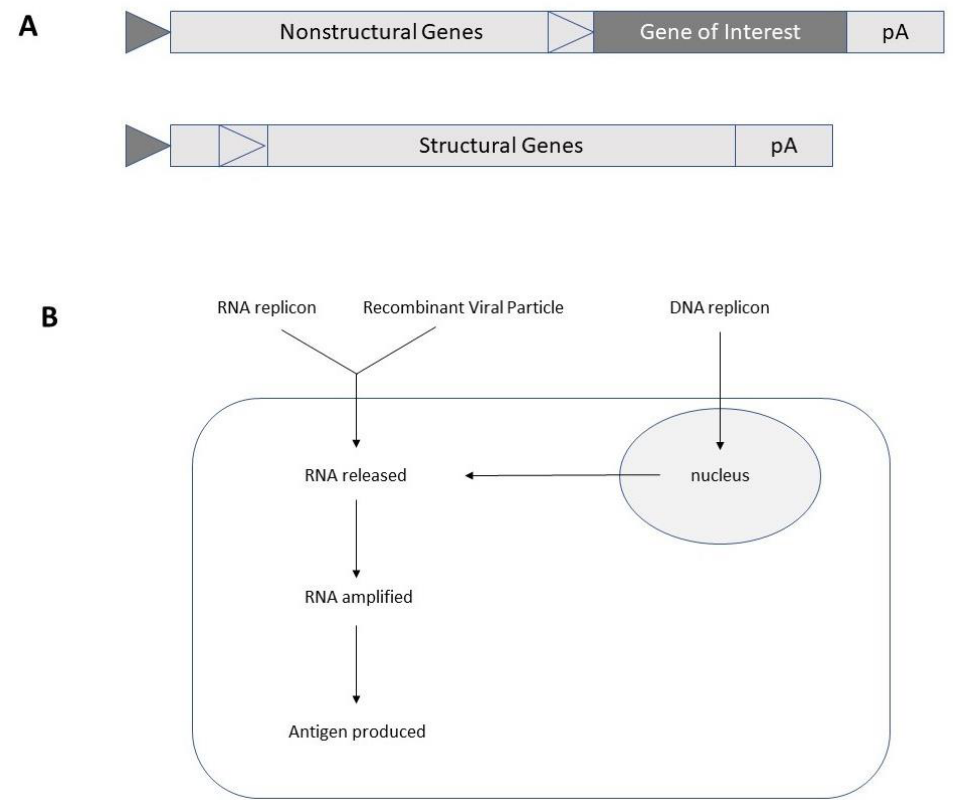
Figure 1. Semliki Forest virus-based expression systems. A. Schematic illustration of expression and helper vectors. Dark triangle, SP6 RNA polymerase promoter; light triangle, Semliki Forest virus (SFV) 26S subgenomic promoter. B. RNA replicon (naked RNA or liposome-encapsulated RNA), recombinant virus particles or DNA replicon (DNA plasmid) can be used for transfection / infection of cell lines and immunization of animals and humans.